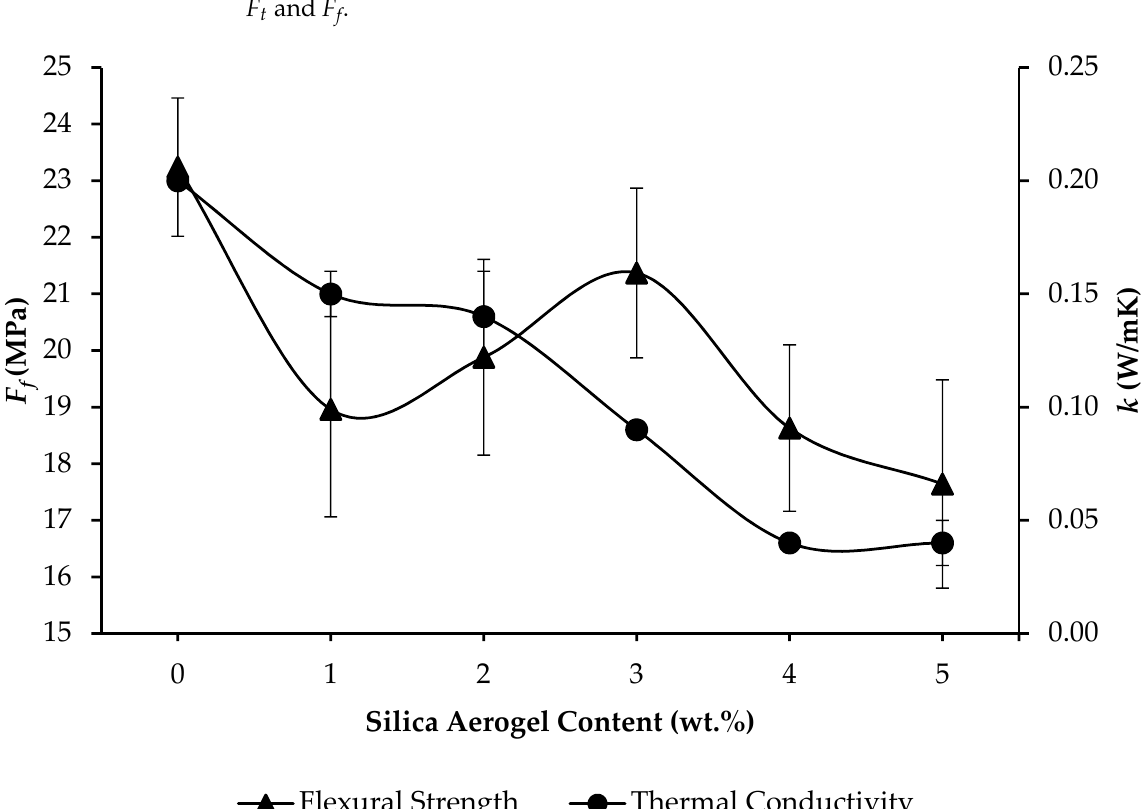
Figure 9. Flexural strength ( F f ) and thermal conductivity ( k ) for the composite insulation samples.